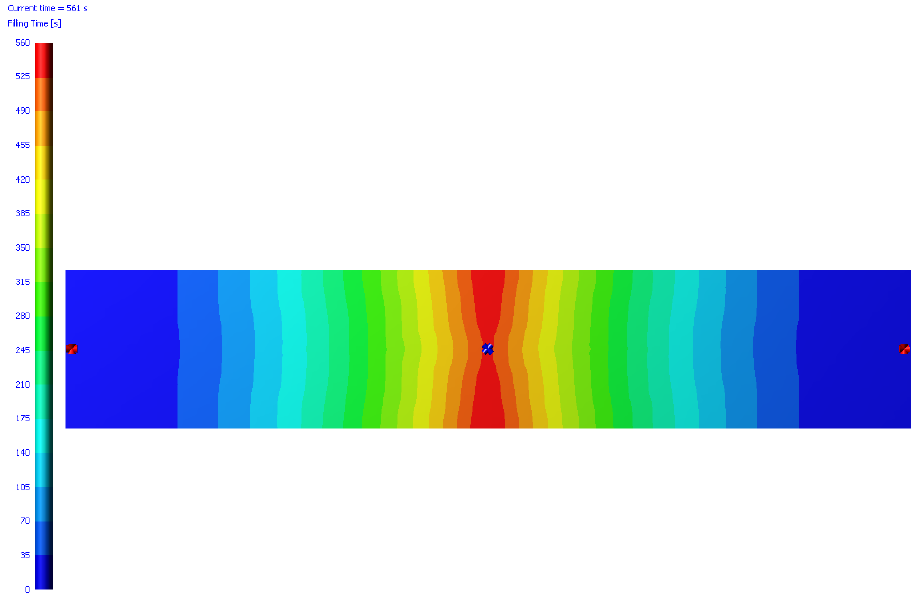
Figure 13. Filling time non-isothermal process.